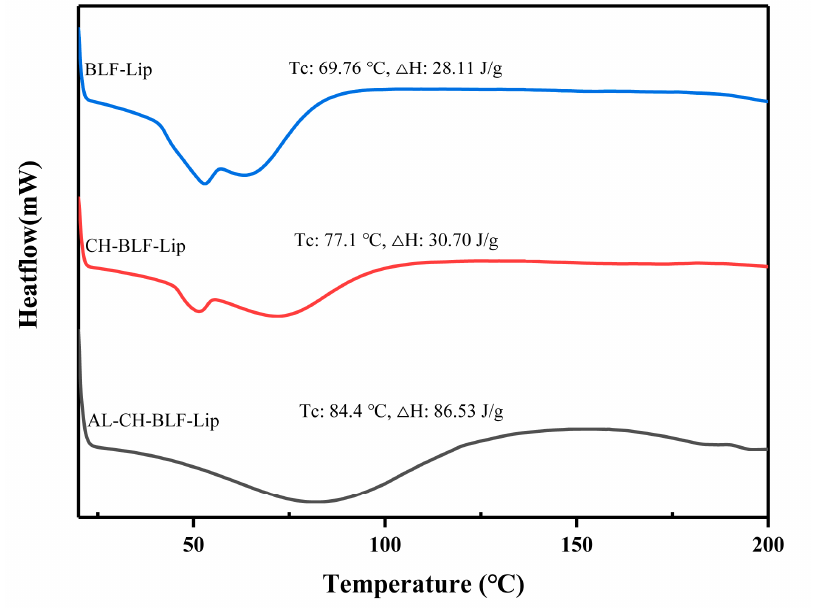
Figure 2. DSC analysis. BLF-Lip, Tc, Phase transition temperature; Δ H, Enthalpy variation. BLF-Lip, BLF-loaded nanoliposomes; CH-BLF-Lip, BLF-loaded chitosan coated nanoliposomes; AL-CH-BLF- Lip, BLF-loaded alginate-chitosan coated nanoliposomes.